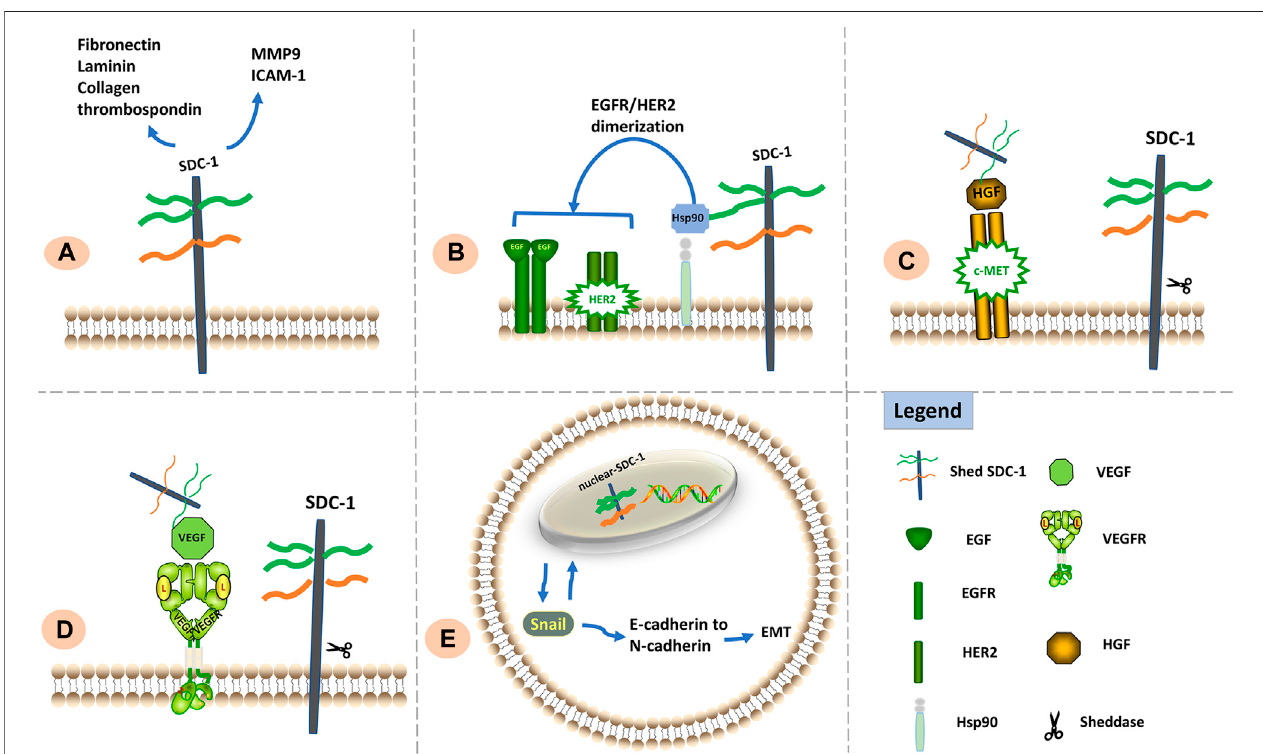
FIGURE2| Signaling functions ofSDC-1relevant tocell metastasis and invasion. (A) SDC-1interacts withavast number ofextracellular matrix molecules such as MMP9, ICAM1, fi bronectin, laminin, thrombospondin, and collagen; such interactions are facilitated via multivalent binding of these molecules to HS chains, thereby in fl uencingcellularadhesiveproperties. (B) TheHSchainsofSDC-1canbindextracellularHsp90topromoteEGFR/HER2dimerizationandinducemetastasis. (C) .Shed SDC-1/HGF complexstimulatescell migrationviathec-Met receptor. (D) . ShedSDC-1bindsVEGFtopromote endothelialcellinvasion. (E) .Nuclear translocation of SDC-1 modulates the EMT via interaction with Snail, resulting in enhanced tumor cell invasiveness.